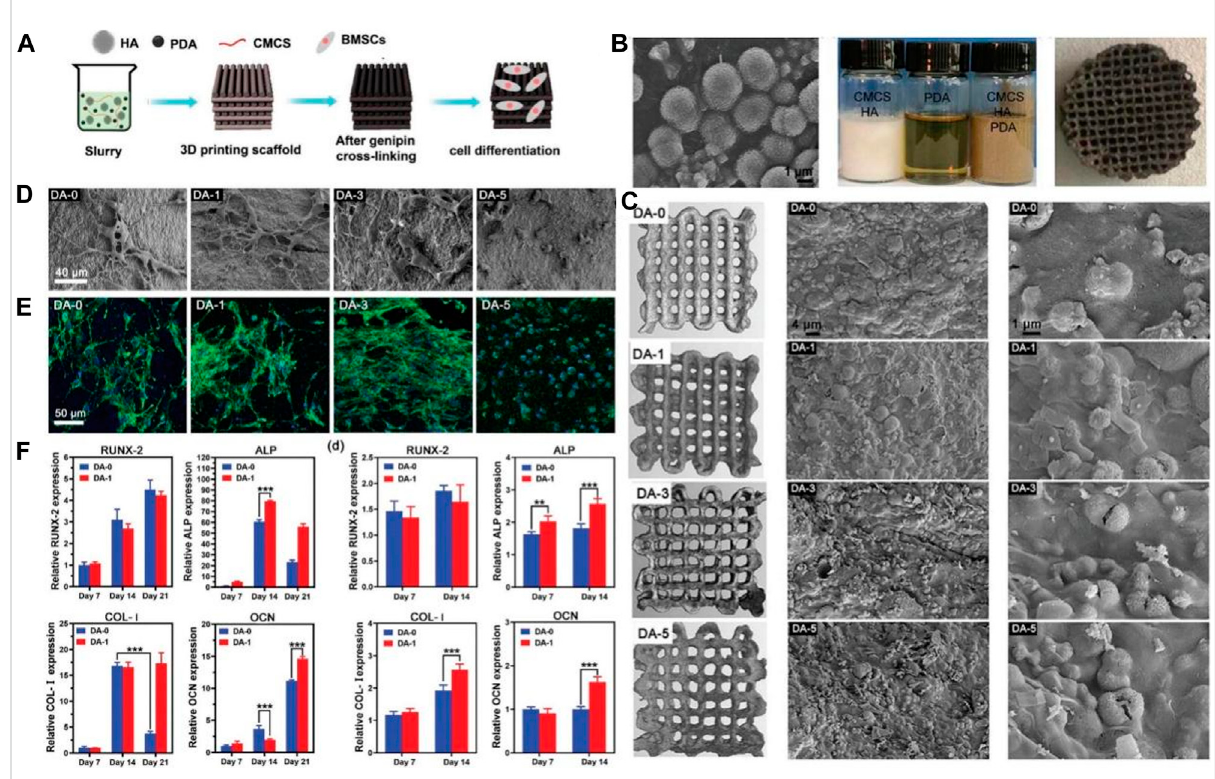
FIGURE 4 HA scaffolds coated with polydopamine for orthopedic applications (Yao et al., 2021). (A) The illustration of HA/PDA/CMCS composite scaffold preparation and application. (B) Appearance of the HA morphology, slurry preparation and HA/PDA/CMCS composite scaffold. (C) Micro-CT and SEM images ofHA/PDA/CMCS compositescaffold. (D) SEM images ofBMSCs on theHA/PDA/CMCS composite scaffold withdifferentPDA content. (E) CLSMphotosofBMSCsontheHA/PDA/CMCScompositescaffoldwithdifferentPDAcontent. (F) Geneexpressionrelevantwithosteogenic differentiation. (Reproduced from the references with